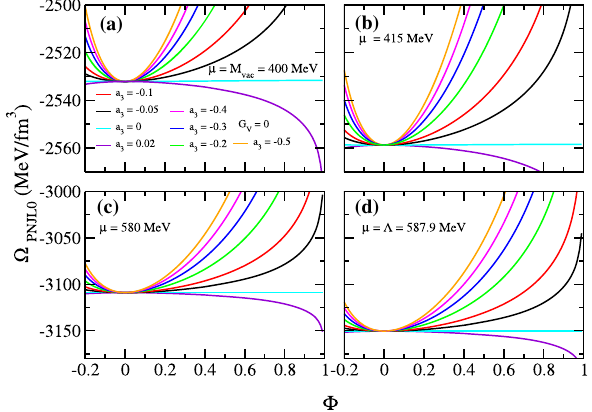
Fig. 2 The same as in Fig. 1, but for G V = 0 . 25 G